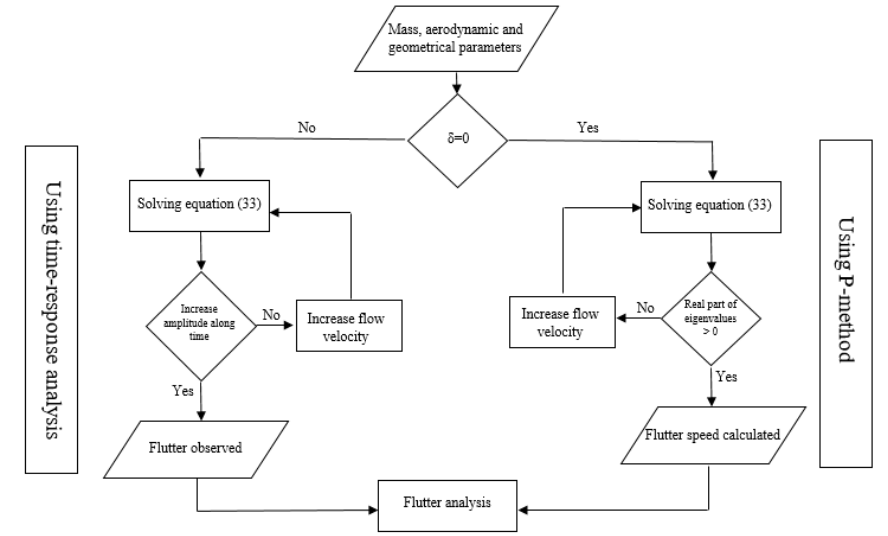
Figure 3. Flutter analysis flowchart.